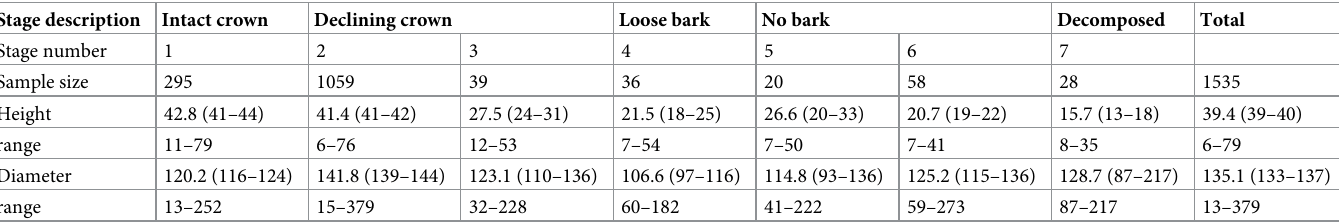
Table 5. Diameter at breast height and total height of nest trees of northern spotted owl in Oregon and Washington, USA, subdivided by decomposition stage. Diameters ( (cid:22) x cm) and heights ( (cid:22) x m) include 95% confidence intervals (parentheses). Data for CLE are